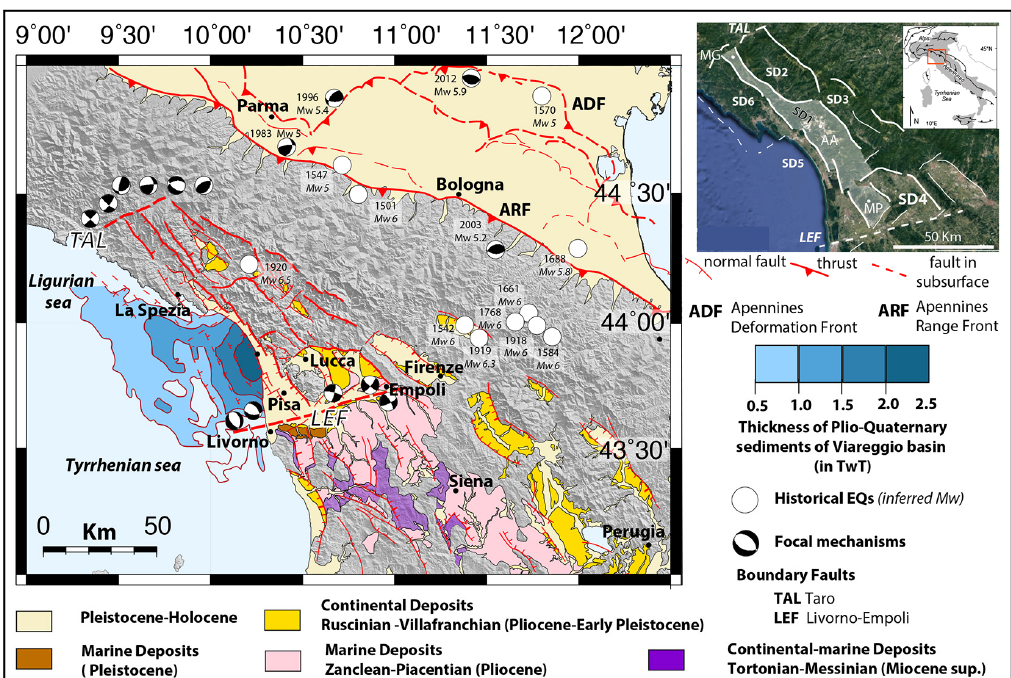
Figure 1. Simplified geological and structural map of the northern Apennines emphasizing the Neogene tectonics in the investigated area. Structural domains (SDs) discussed in the paper are shown in the Google Earth inset. AA: Alpi Apuane; LEF: Livorno–Empoli Fault; MG: Mt. Gottero; MP: Mt. Pisano; TAL: Taro Line. TAL and LEF bound the region of study. Offshore sediment thickness are after [30,31], and earthquakes and focal mechanisms are from the INGV archive [2,32].